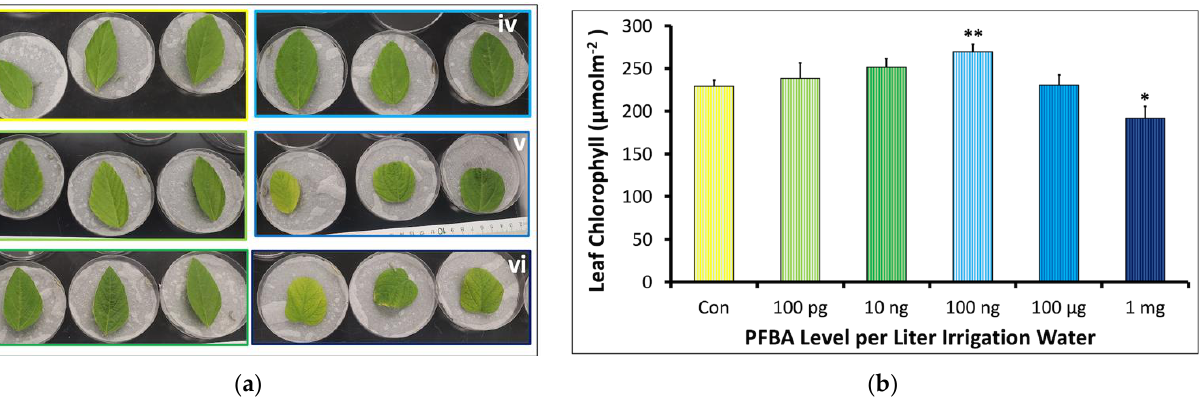
Figure 2. Dose – response relationship between the concentration of PFBA in irrigation water in leaves of soybean plants after 5 weeks of planting and exposure ( n = 3). ( a ) shows leaf morphology, ( i ) control, ( ii ) 100 pg/L, ( iii ) 10 ng/L, ( iv ) 100 ng/L, ( v ) 100 µ g/L, and ( vi ) 1 mg/L groups. Leaves appeared turgid, heavier, and brittle at higher PFBA treatments. About 67% of the leaves in the 100 μ g/L replicates had shrunken edges but green, while the remaining appeared smallish and yellowish ( b ) chlorophyll a content. The * and ** symbols indicate significant difference between the treatment and control at p < 0.05 and p < 0.01, respectively.